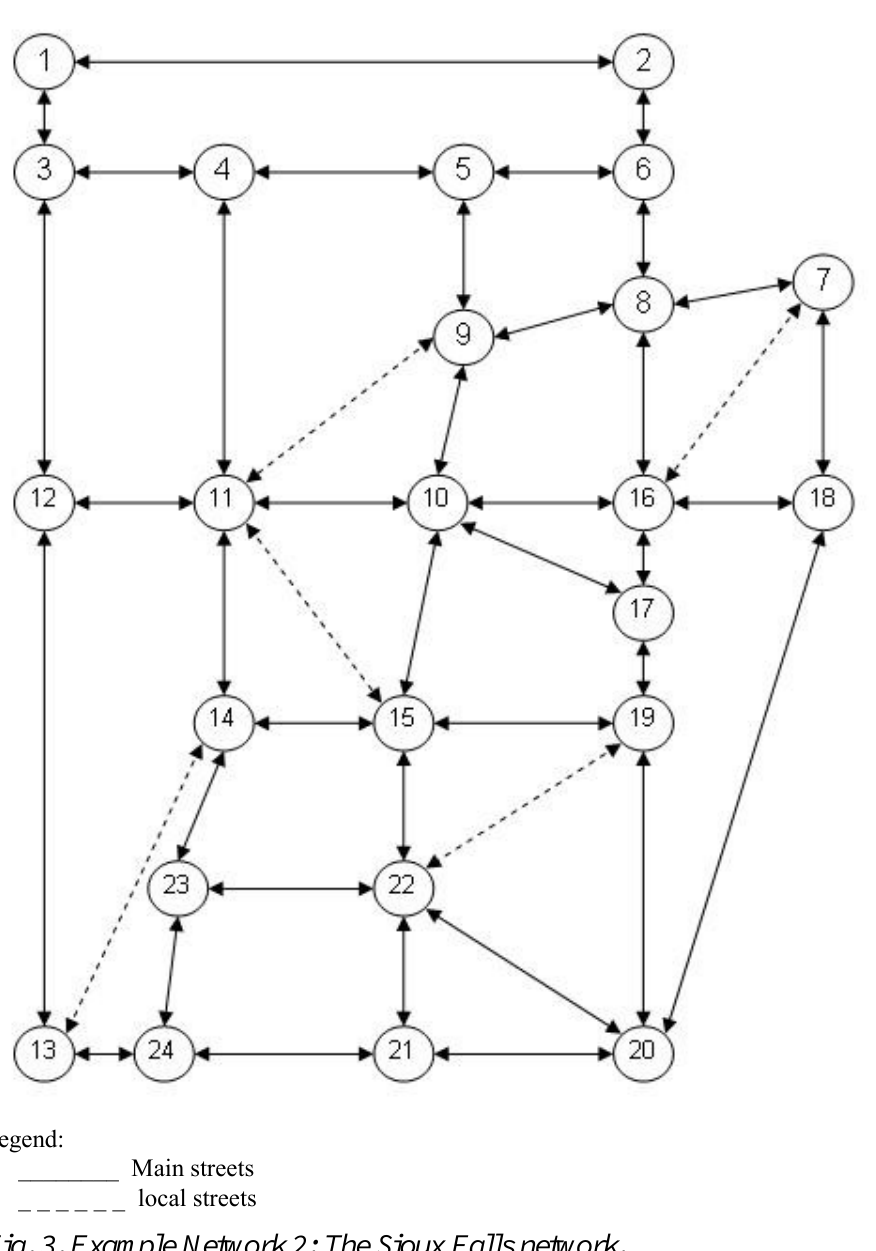
Fig. 3. Example Network 2: The Sioux Falls